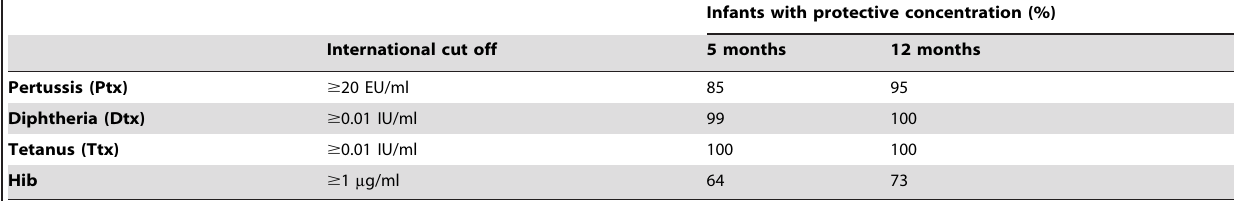
Infants with protective concentration